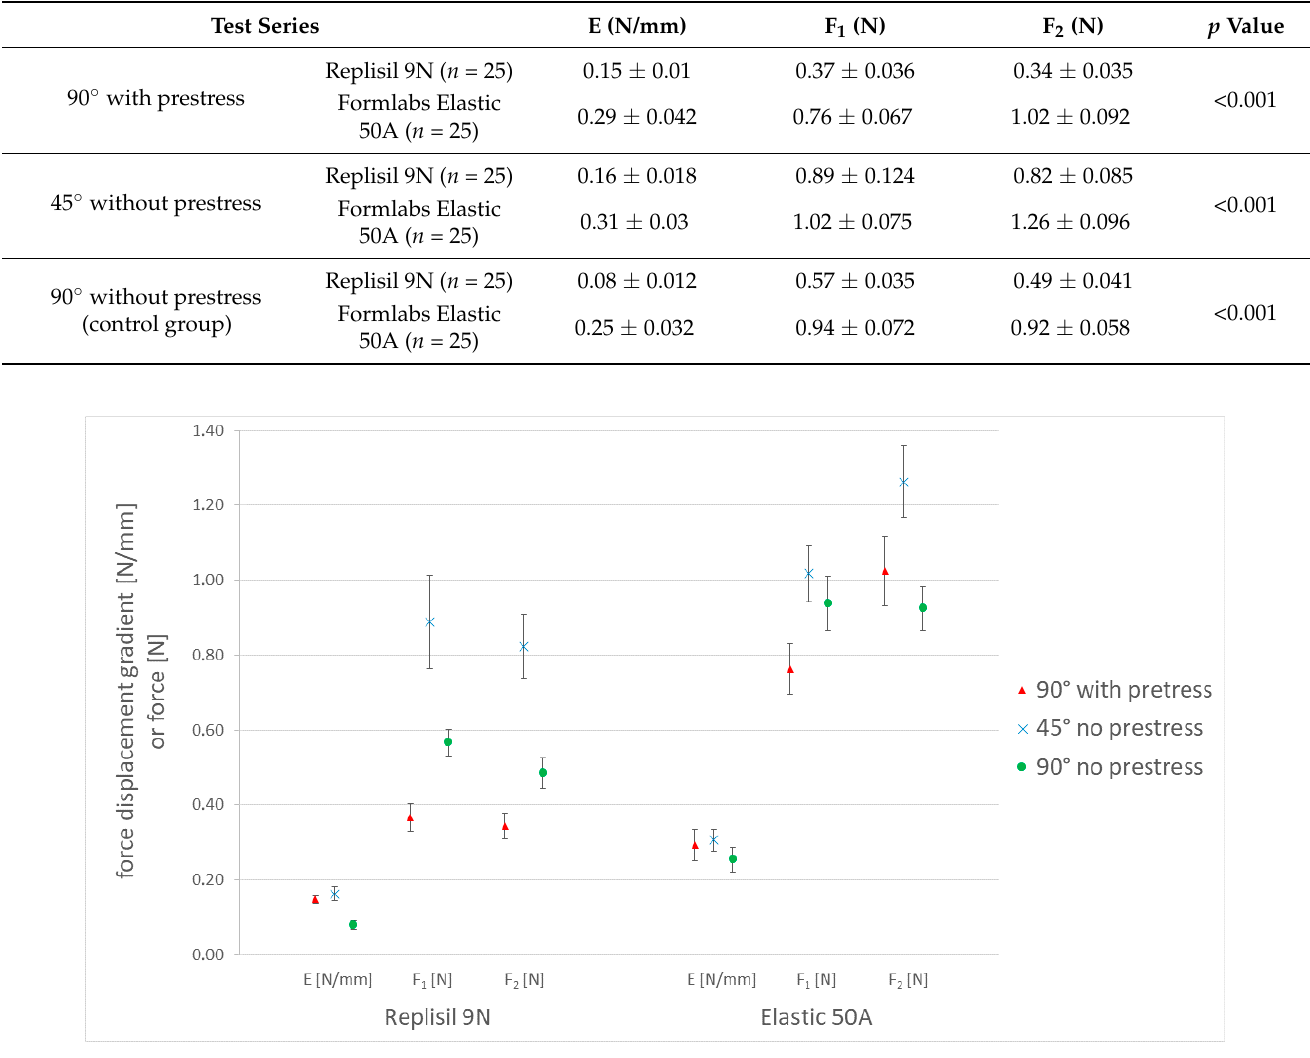
Table 2. Mean test results of the three parameters E, F 1 and F 2 with standard deviations. The gradient of the linear graph part E is in N/mm. The first force maximum F 1 and the following maximum force F 2 are in N.